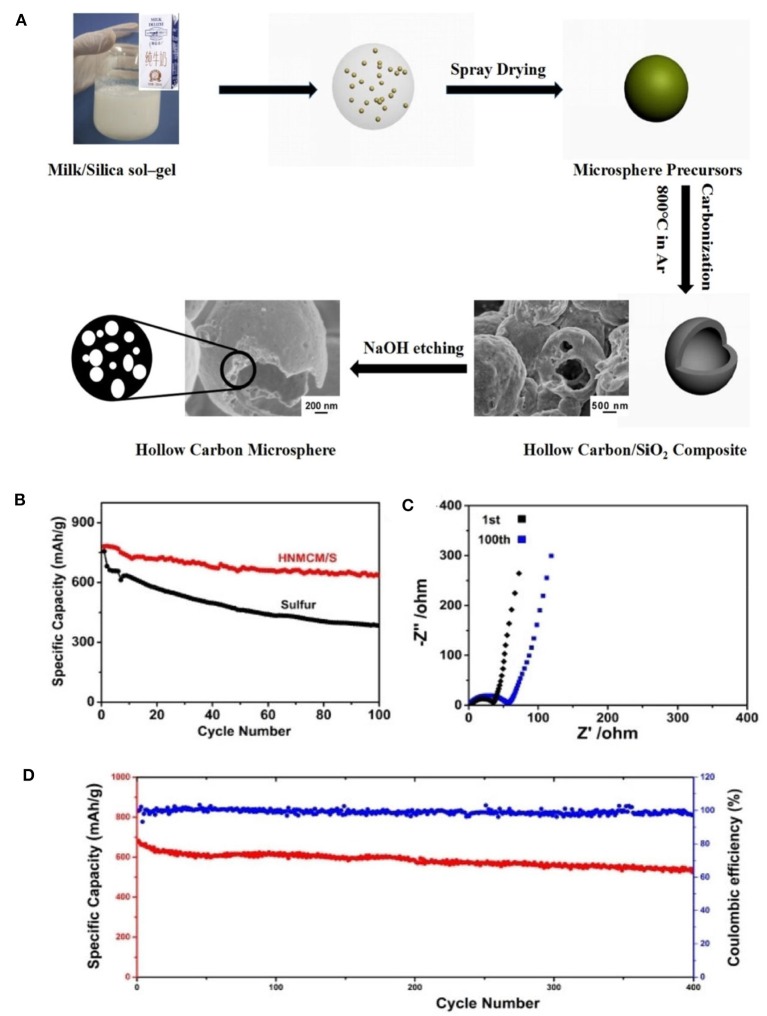
(A) Schematic illustration of fabrication of hollow carbon/SiO2 composites and hollow N-doped mesoporous carbon microspheres by spray drying method. (B) Comparison of cyclic performance of HNMCM/S composite and pristine sulfur electrodes at a rate of 0.5 C. (C) Electrochemical impedance spectra of HNMCM/S cathode before and after l00th cycles. (D) Long-term cyclic performance at a rate of 1 C. From Luo et al. (2018) with permission from Royal Society Chemistry.